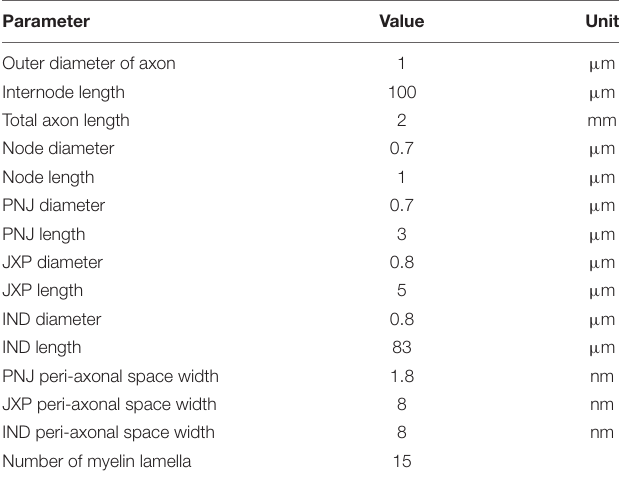
TABLE 1 | Morphological parameters of the axon model. TABLE 2 | Electrical parameters of the axon model.